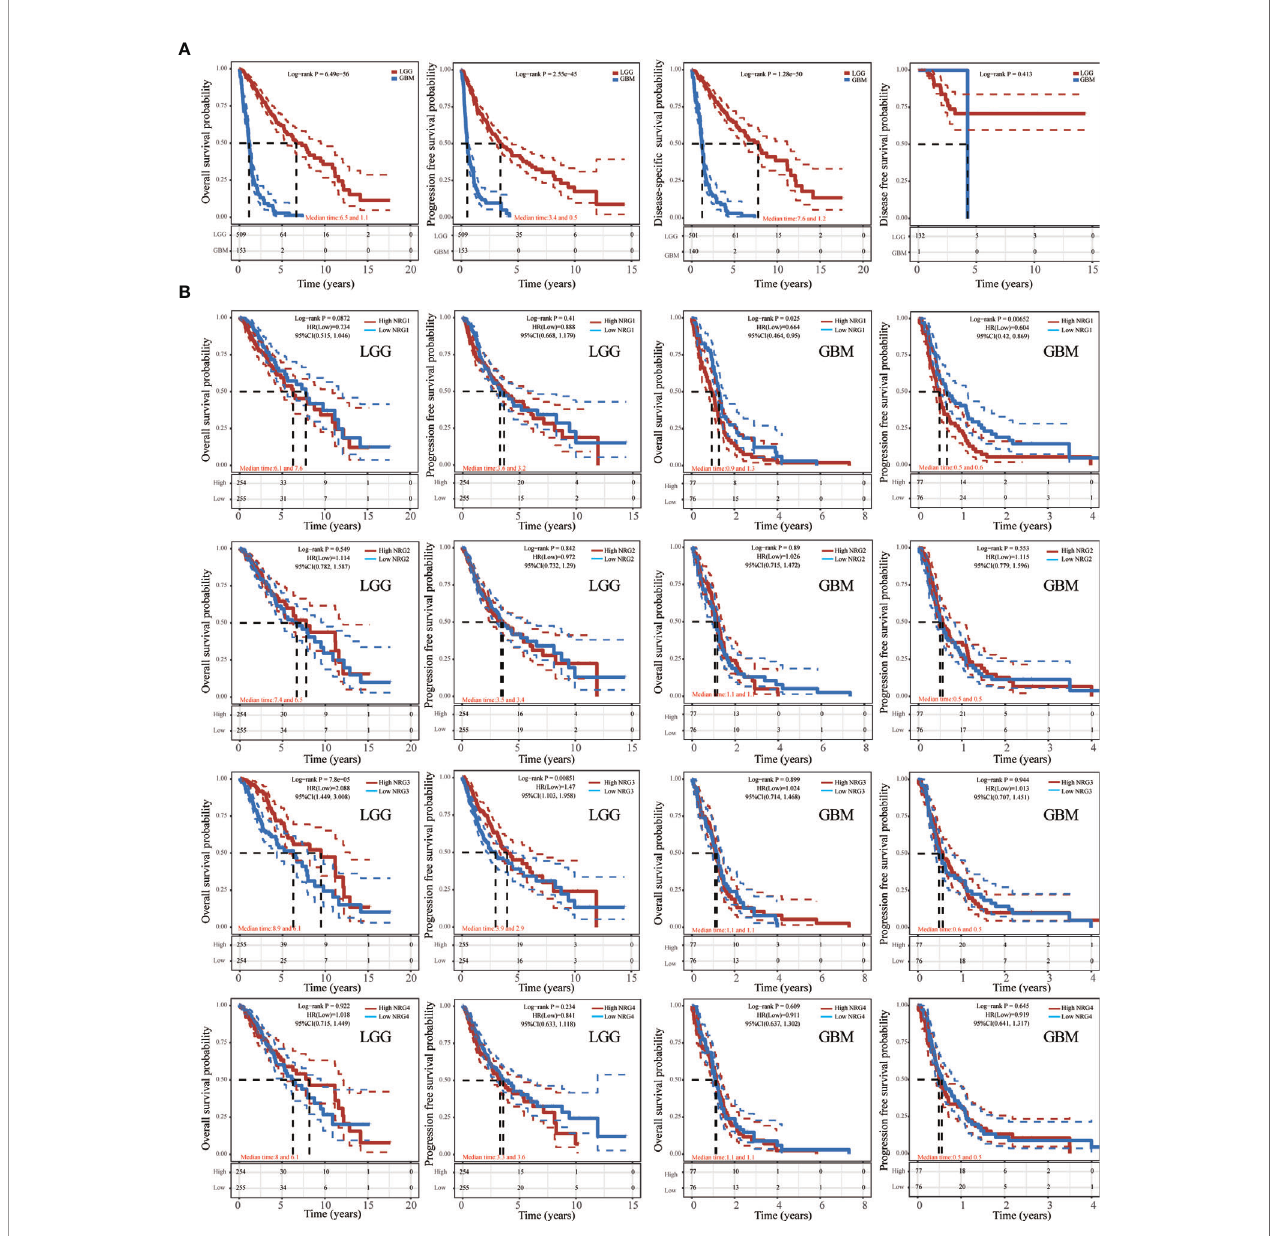
FIGURE 9 | Kaplan-Meier survival analysis of NRGs in LGG and GBM. Kaplan-Meier survival analysis of LGG and GBM, including overall survival (OS), progression- free survival (PFS), disease-speci fi c survival (DSS) and disease-free survival (DFS) (A) . Kaplan-Meier survival analysis of NRG1-4 in LGG and GBM, including OS and PFS (B)